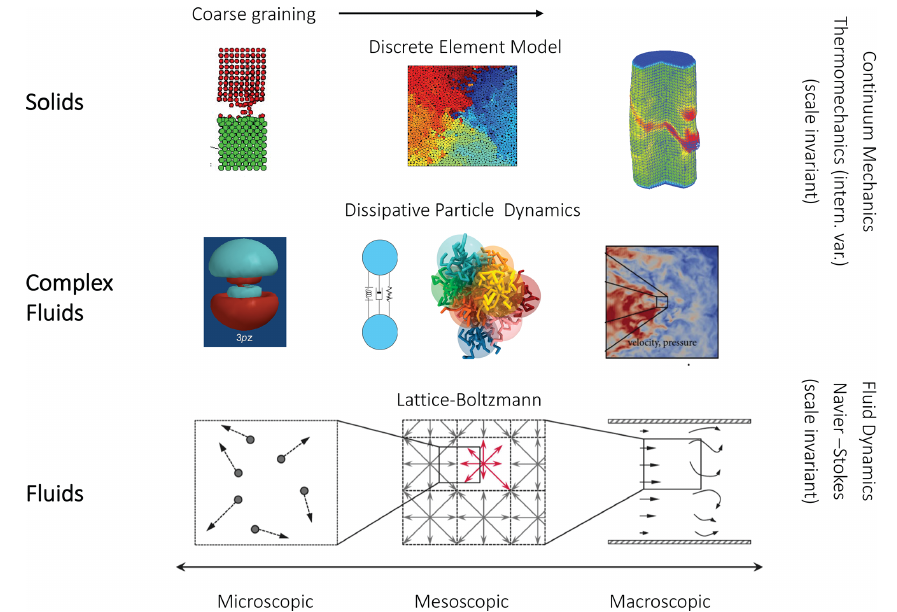
Figure 2. Coarse-graining approaches in continuum and fluid dynamics. The microscale has the richest information and highest degrees of freedom. Coarse graining reduces the complex dynamics to time-evolution equations with a less detailed level of description. In the continuum scale only reduced variables are retained. In the case of the Navier–Stokes equation for fluid dynamics, these are pressure and velocity. The wave mechanics approach presented here is a meso-scale approach that opens the path for an analytical reduction of variables rather than a computational coarse-graining method based on averages. Examples for three different methods are shown. The top row illustrates the simulation of a solid body with a particle flow code (PFC, modified after Durrleman et al., 2006) and the continuum damage model (modified after Lyakhovsky et al., 2015). An incorporation of Arrhenius-dependent thermal regularization on the continuum damage model can be found in Hu et al. (2017). The middle row shows a dissipative particle dynamics approach (modified after Español and Warren, 2017) and the bottom row a lattice Boltzmann homogenization technique (modified after Fitzgerald et al., 2019). Our approach replaces the explicit simulations by considering the meso-scale processes through consideration of non-local effects of cross-diffusion. These effects enrich the upscaling of physics-based macro-scale constitutive equations at the continuum scale. The approach is complementary to the numerical coarse-graining techniques shown in this